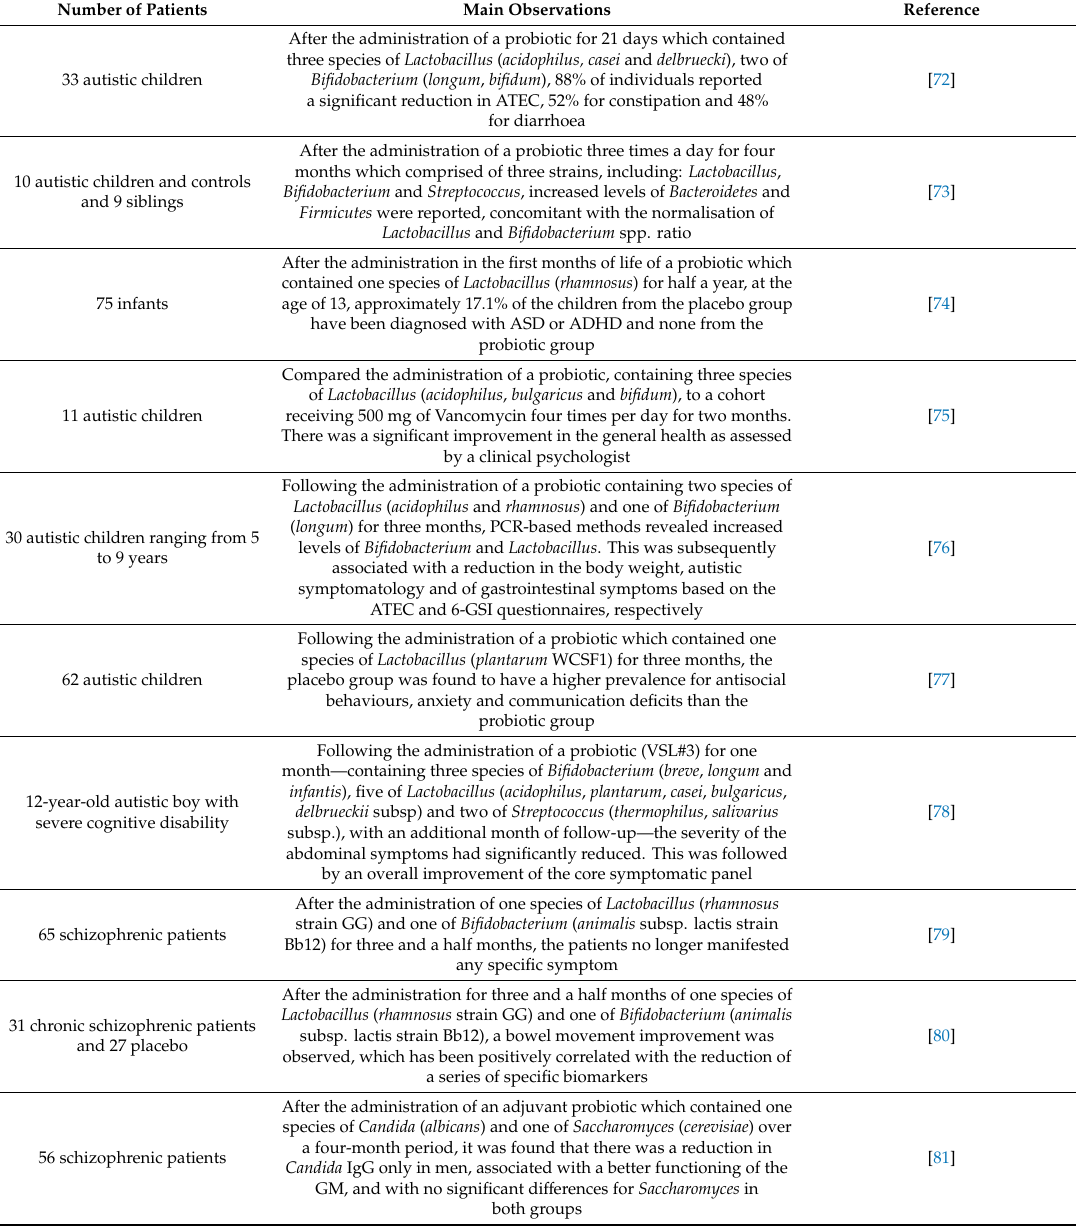
Table 1. The modulatory e ff ects following the administration of probiotics in the regulation of the GBA–HPA